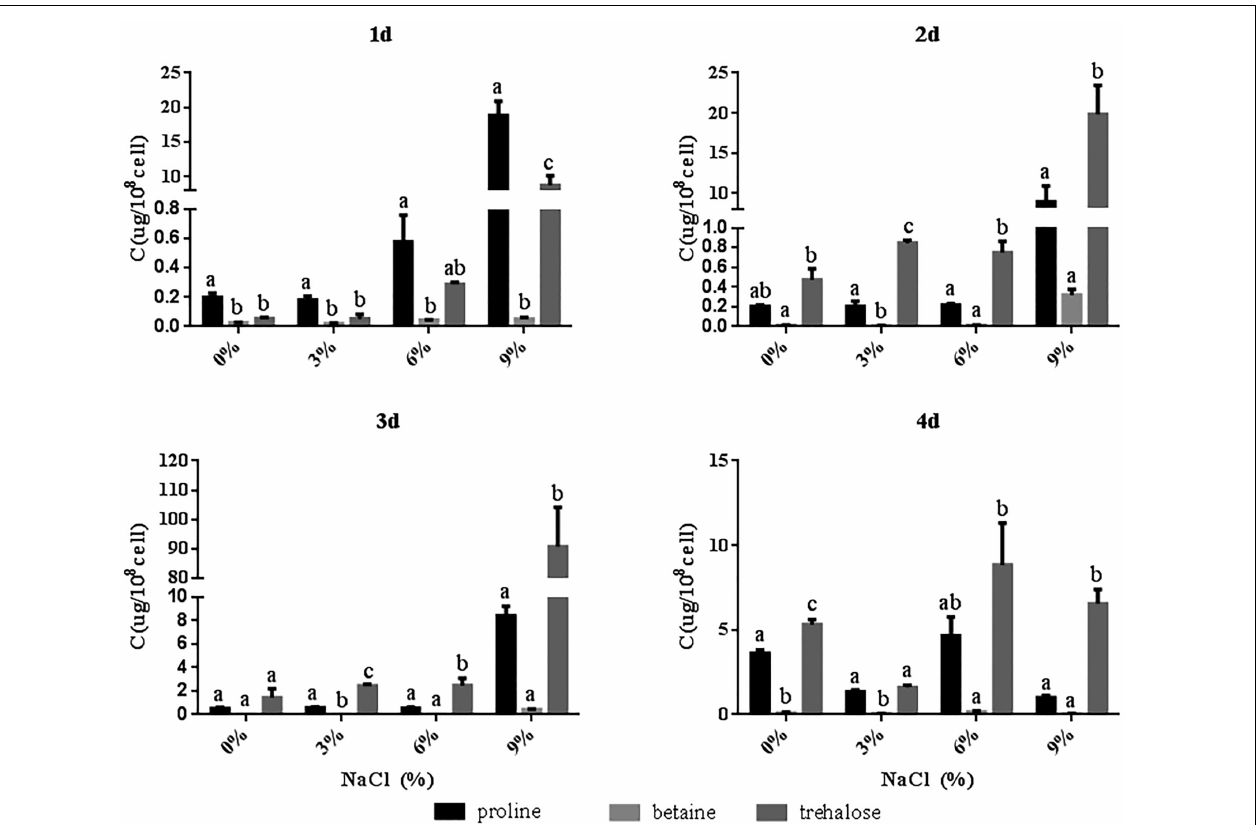
FIGURE 4 | Compatible solutes accumulated by R. aquatilis JZ-GX1 in the presence of different salt concentrations. The vertical bars represent the standard deviations of the averages. One-way ANOVA was performed, and Duncan’s post hoc test was applied. Different letters indicate significant differences ( P < 0.05) among the